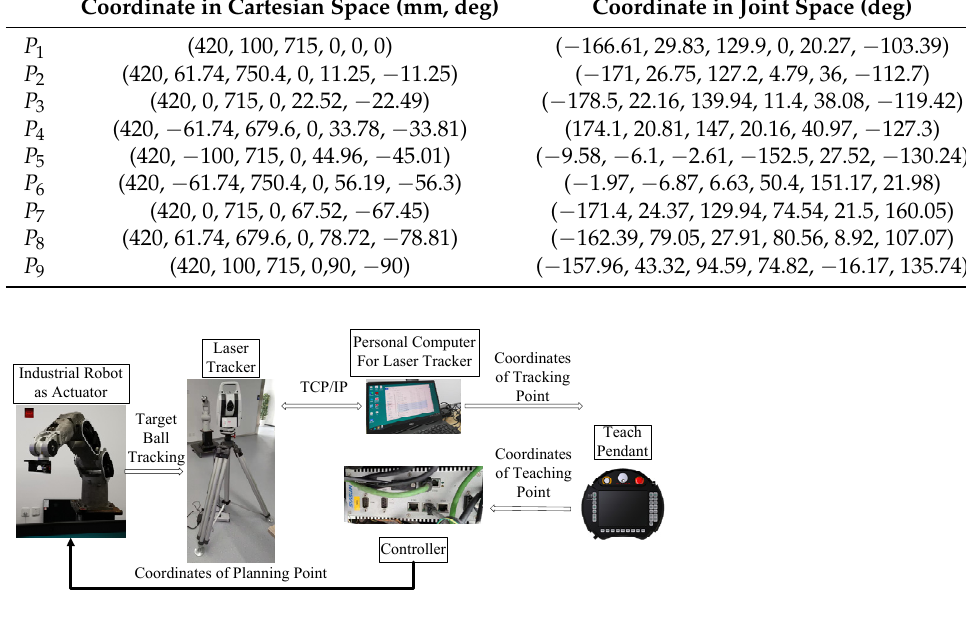
Figure 10. Laser tracker data point acquisition.